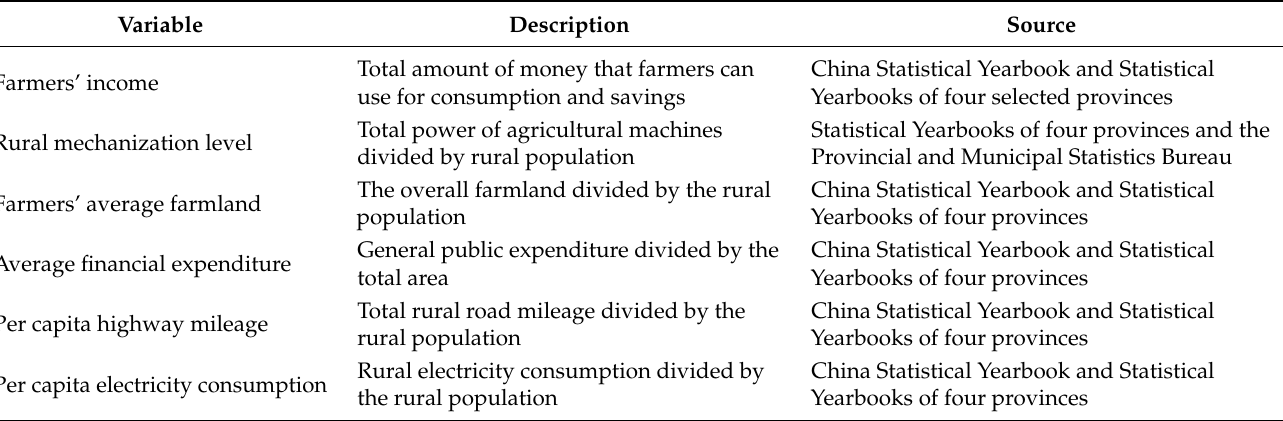
Table 1. Data sources and